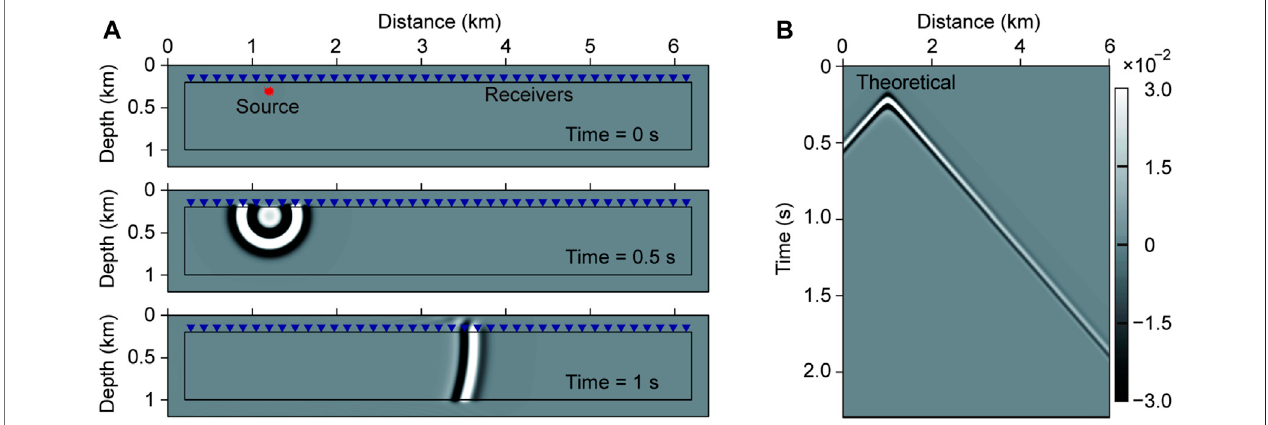
FIGURE 7 | Schematic map of the narrow slice model and wave fi eld record. (A) Snapshots of a point source for the narrow slice model at 0, 500, and 1,000 ms. Thesnapshotsareobtainedby20-layerRD-PML. (B) Shotrecordsbythereceiversalongthehorizontallineofbluetrianglesin (A) .Theshotrecordsareobtainedusinga very large model to avoid boundary re fl ections, which can be regarded as a reference to check the performance of different types of PML.